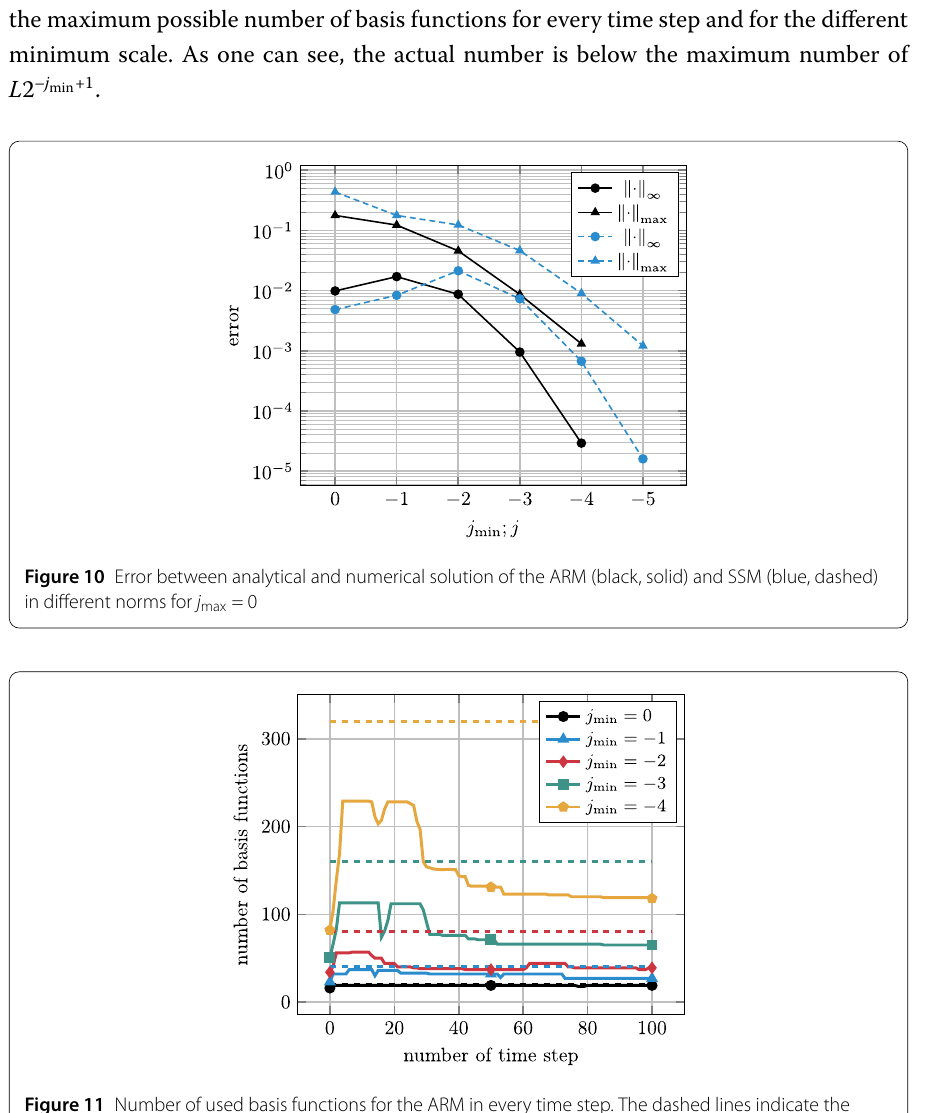
Figure 11 Number of used basis functions for the ARM in every time step. The dashed lines indicate the maximum possible number of basis functions with the corresponding value of j